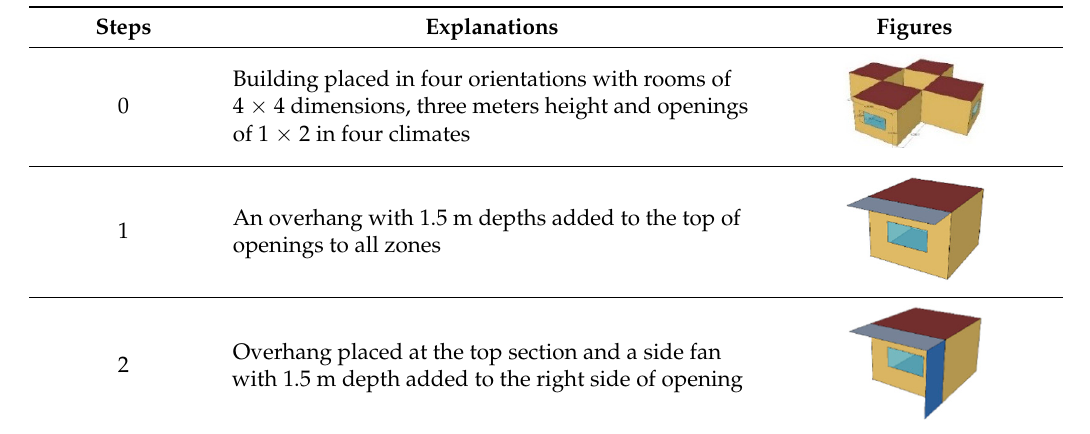
Figure 6. Thermal load of zones without Iwan [KW/Yearly]. Table 7. Steps of Iwan forms placement.